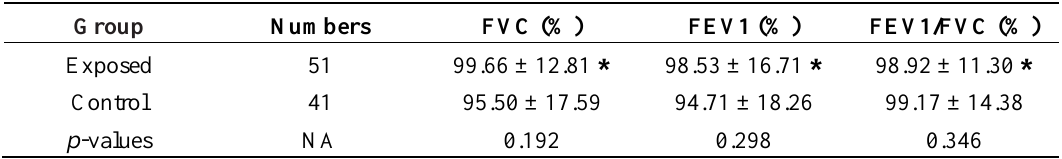
Table 8. The results of pulmonary function test in two groups in Yicheng Survey